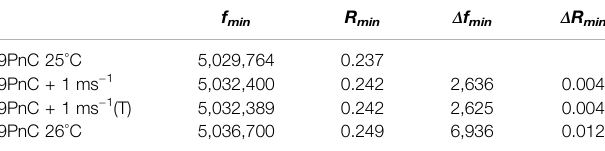
TABLE 3 | Characteristic values of the 9PnC to